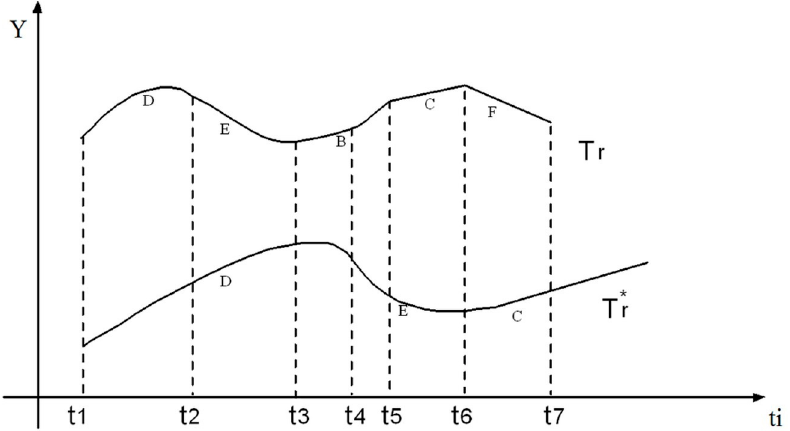
Figure 8. Temporal synchronization of segments.